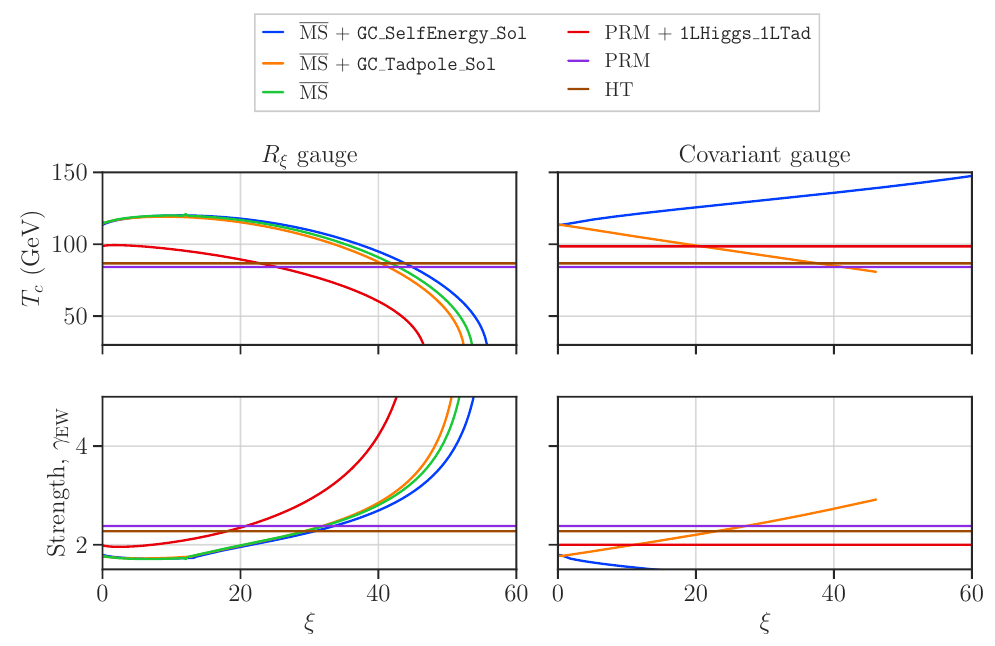
Figure 2 . The gauge dependence from different methods for the critical temperature (top) and transition strength (bottom) in R (left) and covariant gauge (right) for the benchmark point in ξ eq.